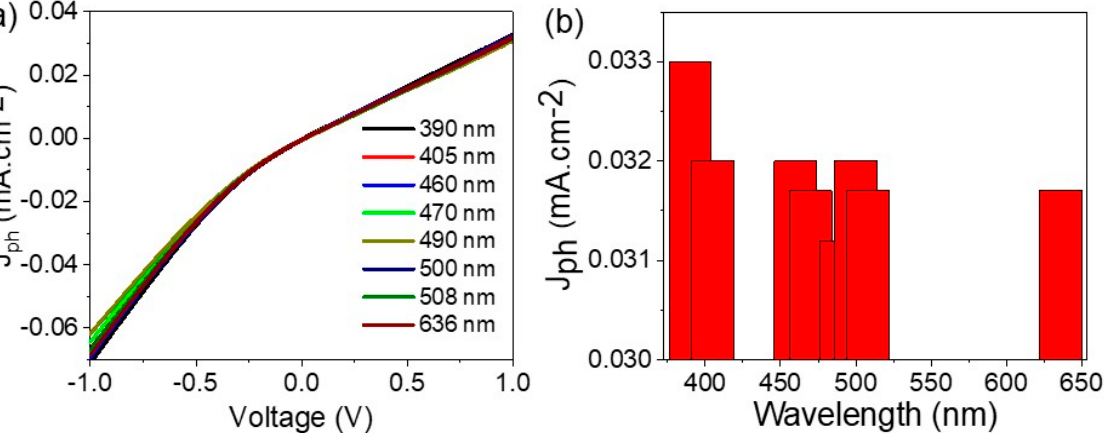
Figure 6. ( a ) The effect of monochromatic light on the prepared optoelectronic device and ( b ) the relation of various wavelengths and the produced current density values at 1.0 V.